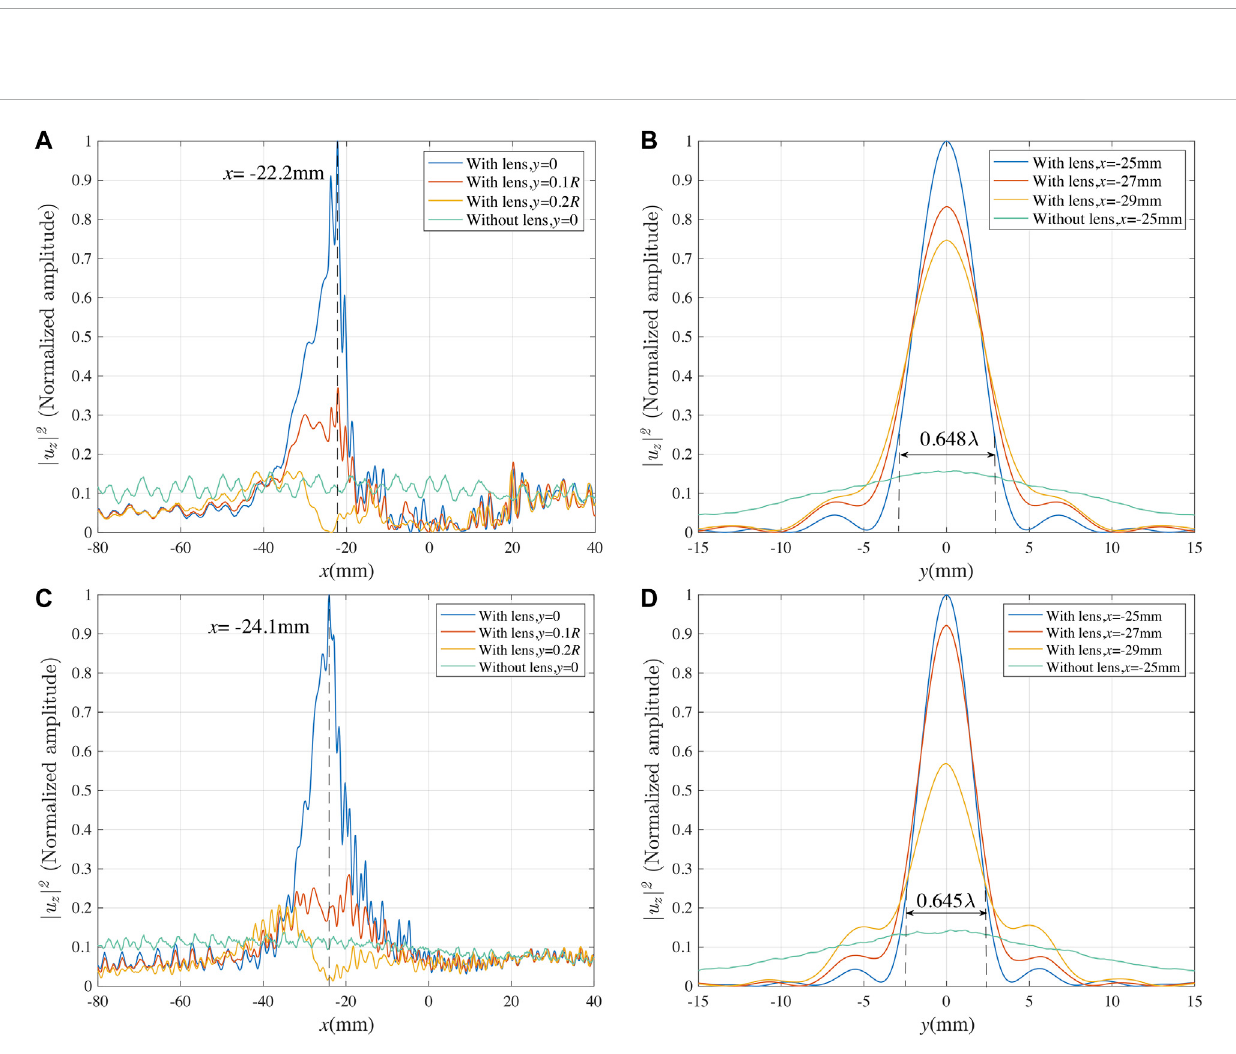
FIGURE 9 The spatial distribution of | u z | 2 along the x and y directions: (A) and (B) correspond to the A1-wave-based Luneburg lens at 1 MHz; (C) and (D) correspond to the S2-wave-based Luneburg lens at 1.9 MHz.